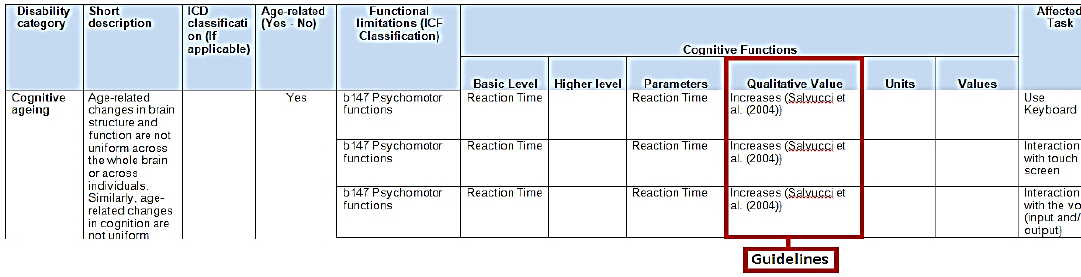
Figure 3. Enriched Cognitive AUM. Note: Salvucci et al. [42].